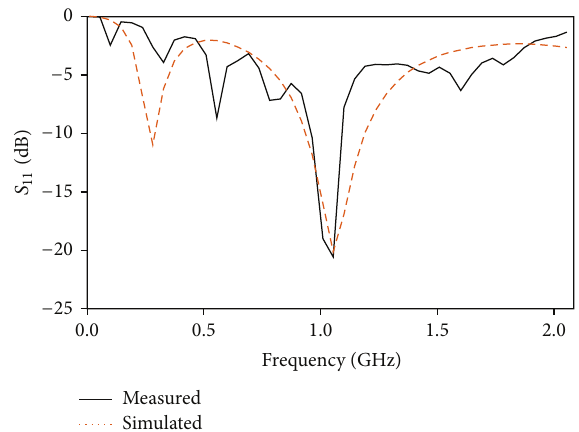
Figure 5: Measured S 11 response of the proposed antenna.